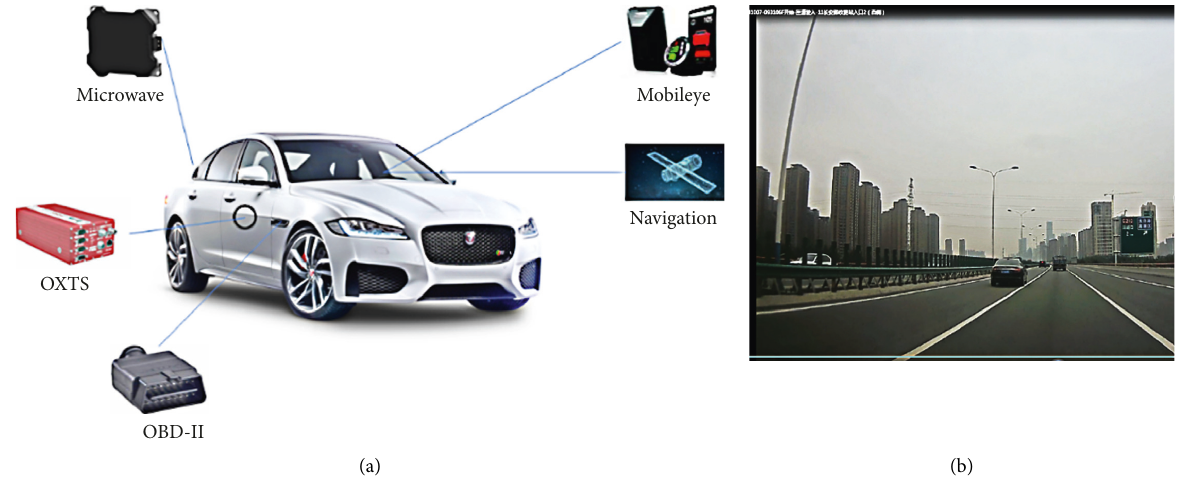
Figure 1: Data collection: (a) vehicle sensors and (b) images from in-vehicle